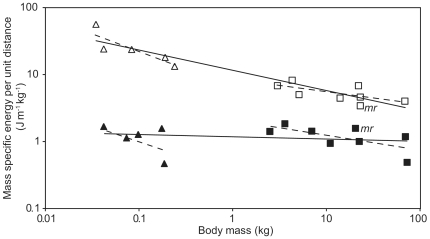
The relationship between the mass specific cost of transport and body mass.Open symbols represent metabolic energy (E
met), closed symbols mechanical energy (E
mech, CM), triangles are species with <1 kg body masses [3] and squares species>1 kg [6], [7]. Data for Macropus rufus are labelled with mr symbols. Individual trend-lines calculated from the ANCOVA coefficient tables are for the E
mech, CM data; y = 1.17x
−0.03 (all data grouped), y = 2.06x
−0.22 (species>1 kg) and y = 0.391x
−0.46 (species<1 kg). For the E
met data the trend-lines are y = 11.38x
−0.30, y = 8.38x
−0.19 and y = 6.55x
−0.53 for all data grouped, species>1 kg and species<1 kg respectively.